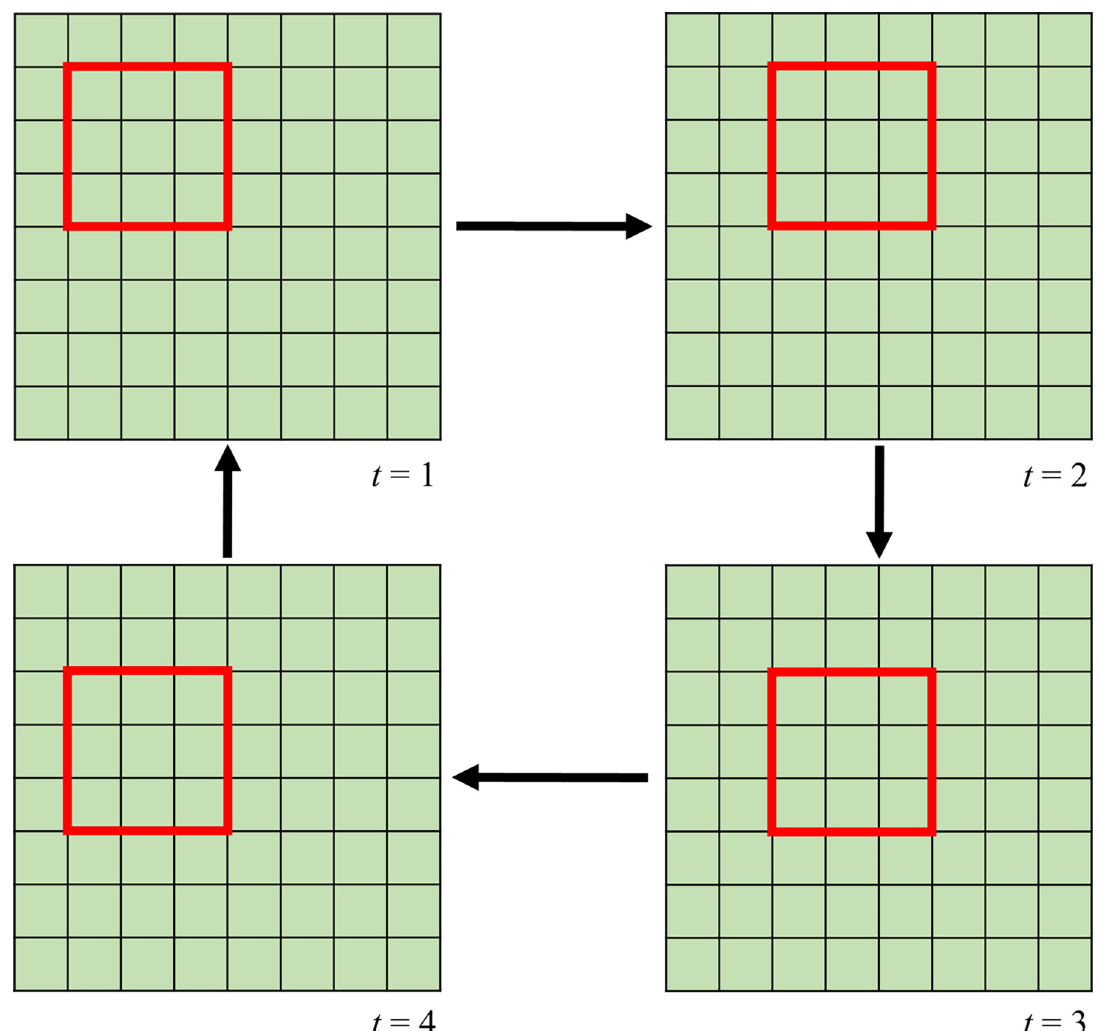
Fig 1. Schematic view of a block movement in this study in order to consider cell movement ability (see text for more explanation).